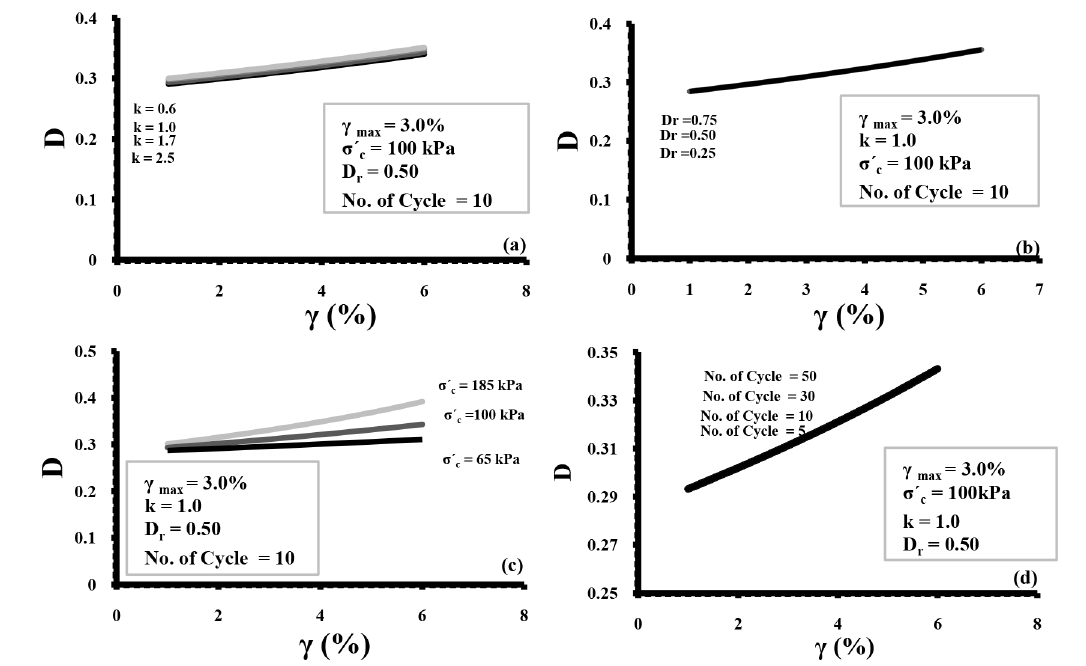
Fig. 14. Damping ratio versus shear